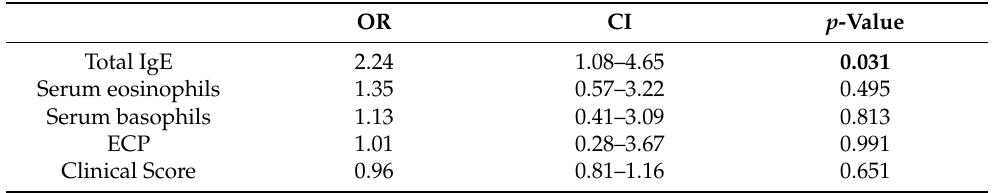
Table 3. Association of nasal eosinophilia with markers of atopy (serum eosinophils, serum basophils, ECP) and Clinical Score. ECP eosinophilic cationic